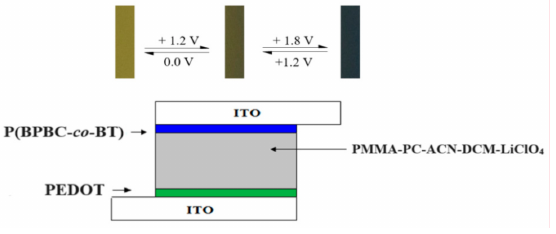
Figure 2. Schematic diagrams of the P(BPBC- co -BT)/PEDOT